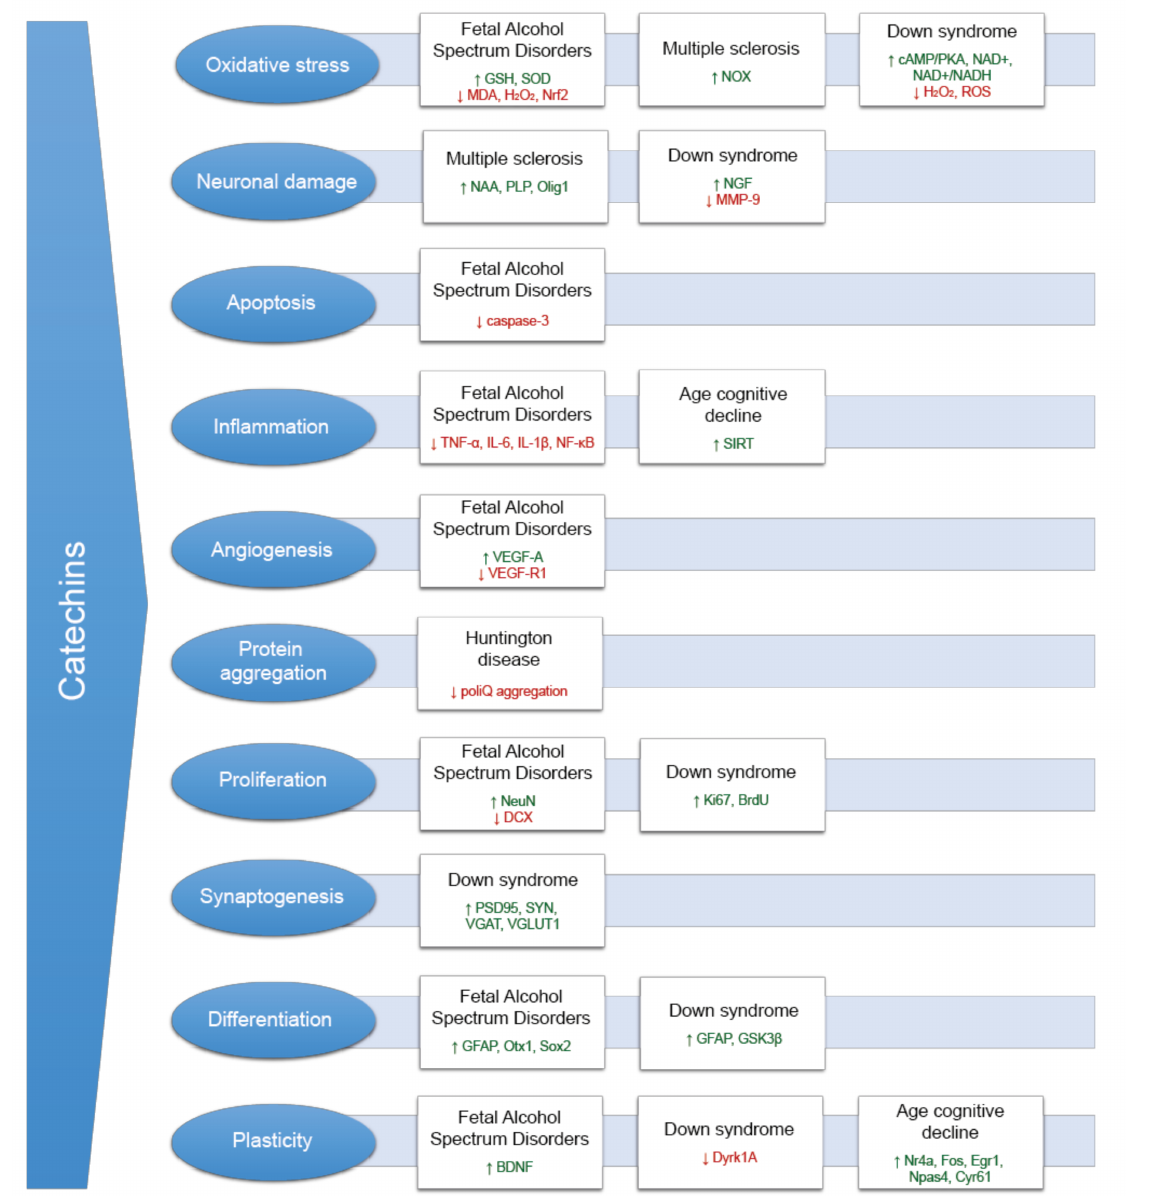
Figure 2. Molecular mechanisms of catechin action and changes in related biomarkers in different neurological